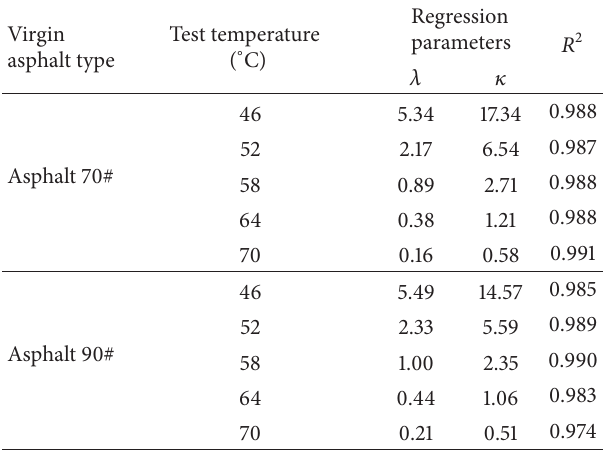
Figure 9: Graph of calculated values versus measured values.